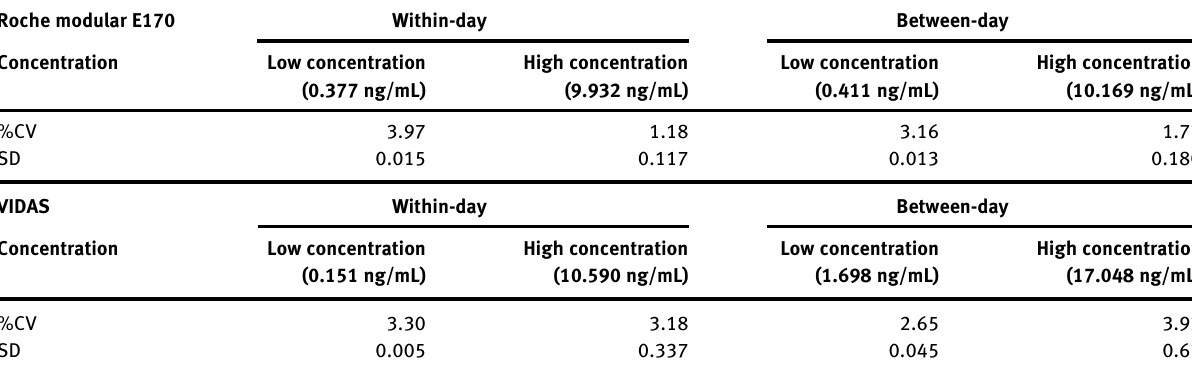
Table  : Within-day and between-day assay precision at low and high concentration for Roche Modular E  and VIDAS. Roche modular E